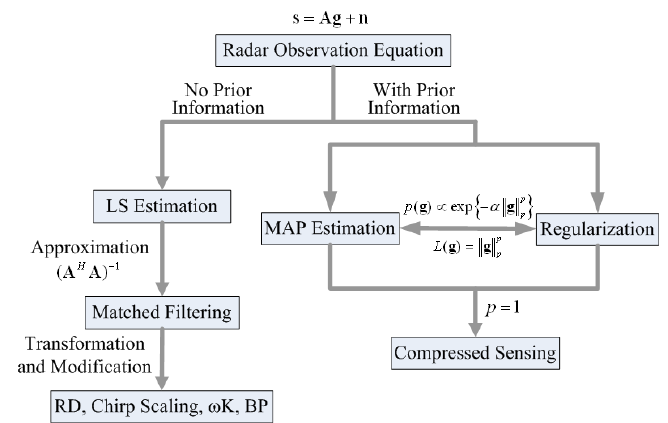
Figure 4. Block diagram and relationship of the radar imaging methods.